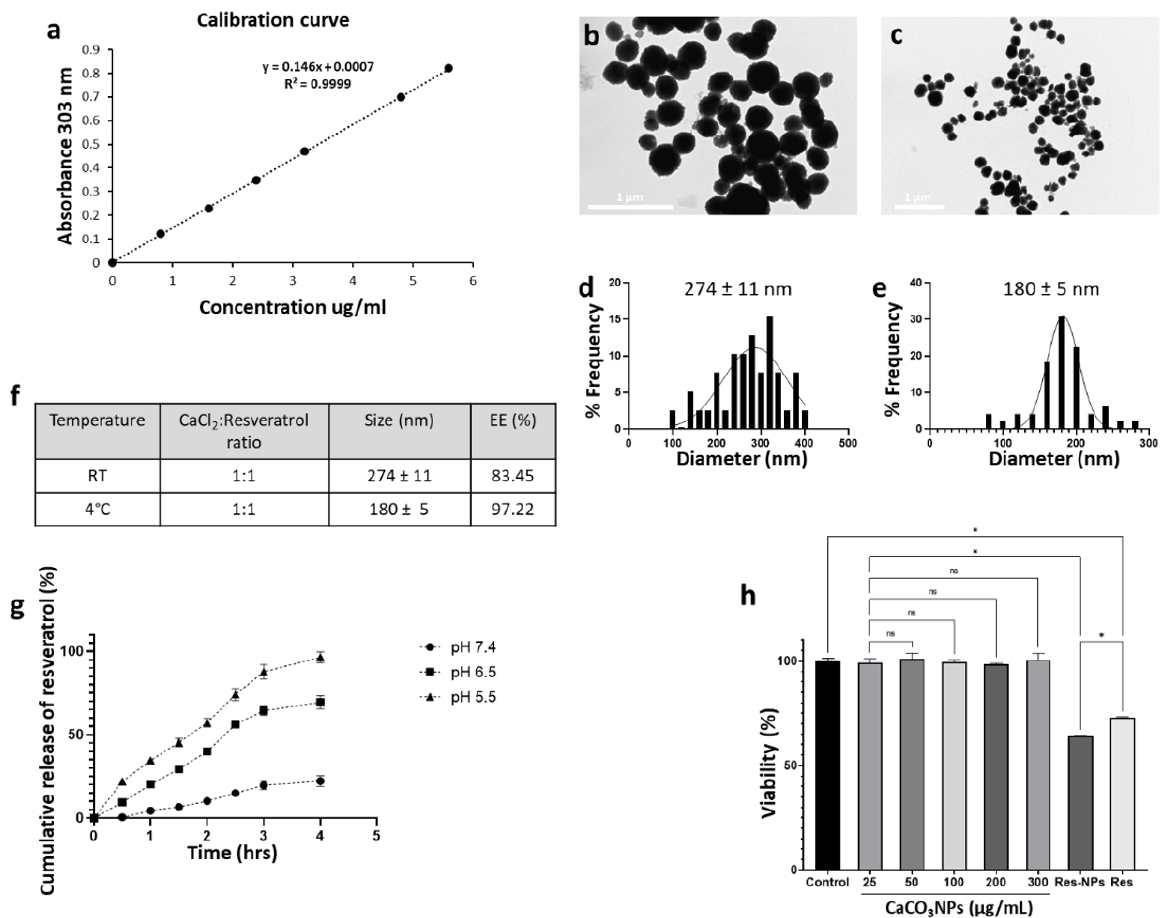
Figure 8. Preparation and characterization of Res-loaded CaCO 3 NPs. Calibration curve of Resvera- trol ( a ). TEM image and relative size distribution of Res-loaded CaCO 3 NPs synthesized at room temperature ( b , d ) and 4 °C ( c , e ). Average size and EE (%) for CaCO 3 NPs synthesized at RT and 4 °C ( f ). In vitro evaluation of Res release at different pH values (pH = 7.4, pH = 6.5, pH = 5.5) ( g ). MTT assay of U87 cells after 24 h of exposure to increasing concentrations of CaCO 3 NPs (25; 50; 100; 200; 300 ug/mL), 100 μM of Res loaded into CaCO 3 NPs (Res-NPs) and free (Res) ( h ). * p < 0.05; ns, not significant; one-way ANOVA test.